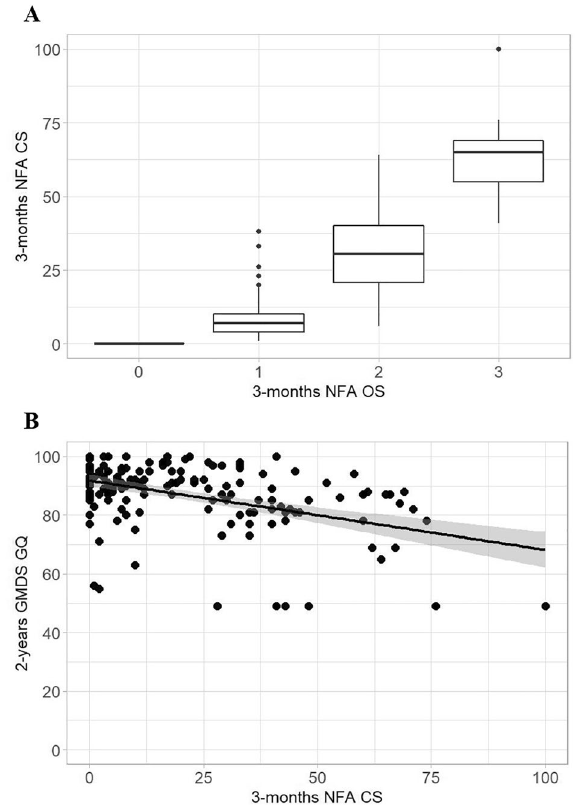
Figure 2. Panel ( A ) Distribution of NFA CSs at three months of CA according to NFA levels. Panel ( B ) Relationship between the NFA CS and GMDS GQ score at 2 years of CA. The black line represents the estimated linear